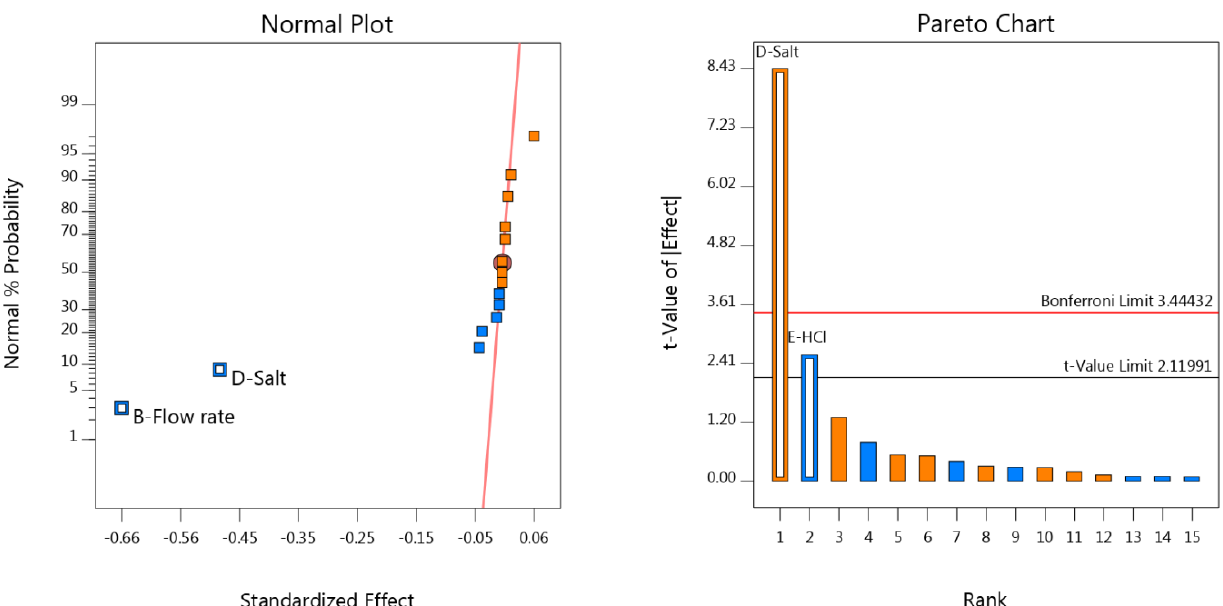
color code: orange for positive, blue for negative). The half-normal plots could help indi- cate the size of the effect, because all the factors were on the same side of the red line.